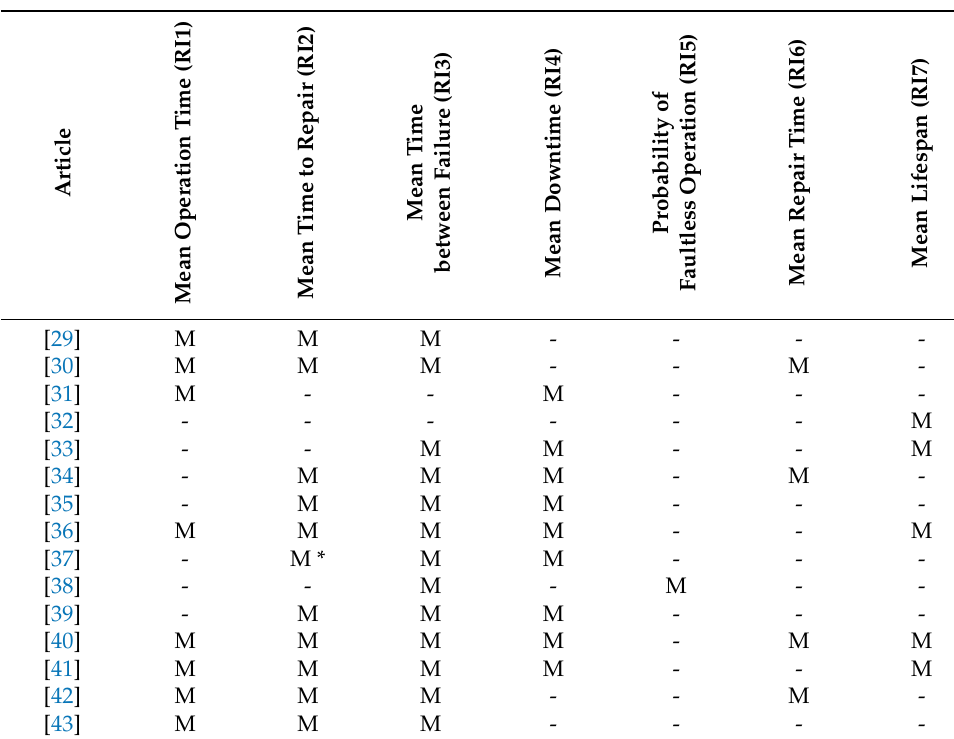
Table 1. Evaluation